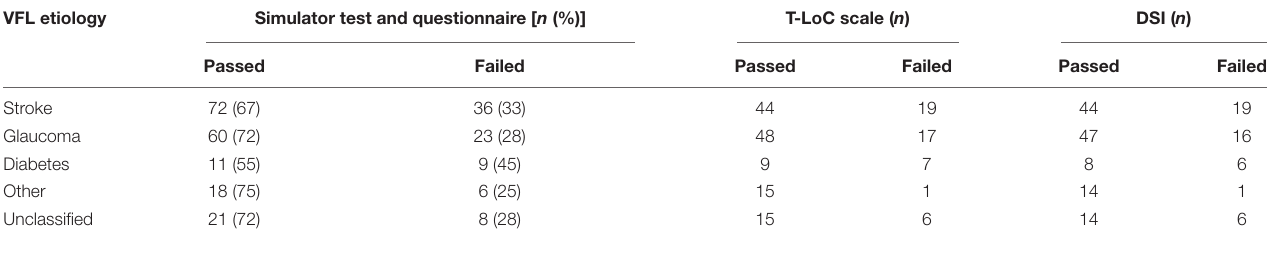
TABLE 4 | Numbers of participants who completed each assessment according to driving simulator test pass or